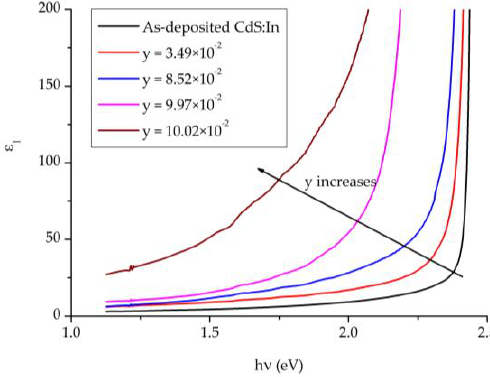
Figure 12. The real part of the dielectric constant of CdS 1−y Te y thin films of comparable thickness but different composition besides that of a CdS:In thin film.